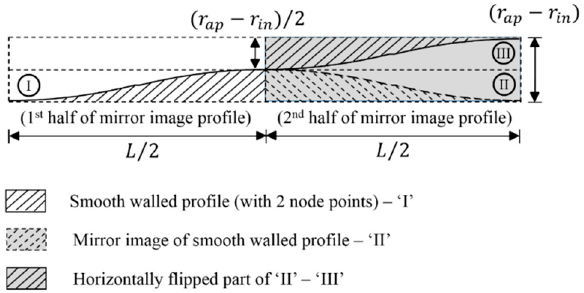
Figure 2. Steps to design a mirror image profile.